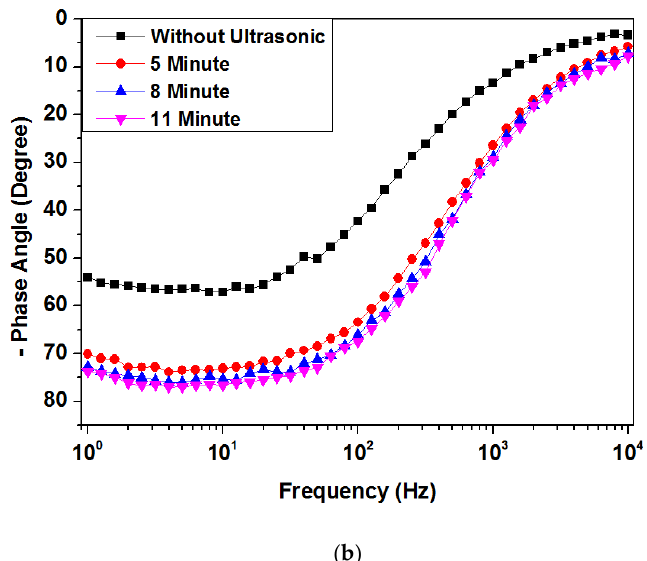
Figure 8. Bode Plots ( a ) log |z| vs. log f and ( b ) phase angle vs. log f for ultrasonic treated TiN coating at 16 kHz for various exposure times.